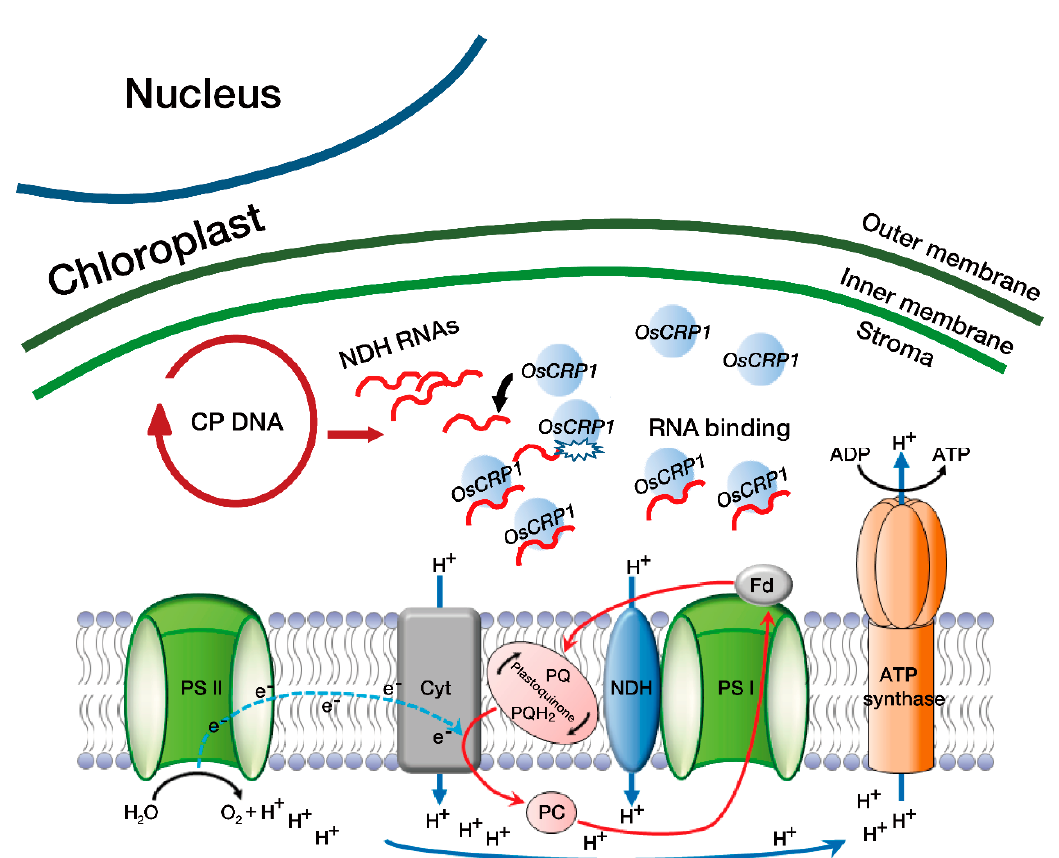
Figure 6. Schematic representation of NDH-dependent CET in OsCRP1 overexpressing plants under abiotic stress conditions. In OsCRP1 overexpressing plants, binding affinity of OsCRP1 to NDH complex RNAs was increased under stress conditions, leading to stabilization of transcripts from NDH complex genes. Hence, the activity of NDH-dependent CET was increased, and protons from the stroma were transferred into the thylakoid lumen, resulting in acidification. The protons drive ATP synthesis, maintaining an optimal NADPH/ATP ratio. Drought and cold stress both induce an increase in ATP demand that may be fulfilled by NDH-dependent CET around photosystem I (PSI).